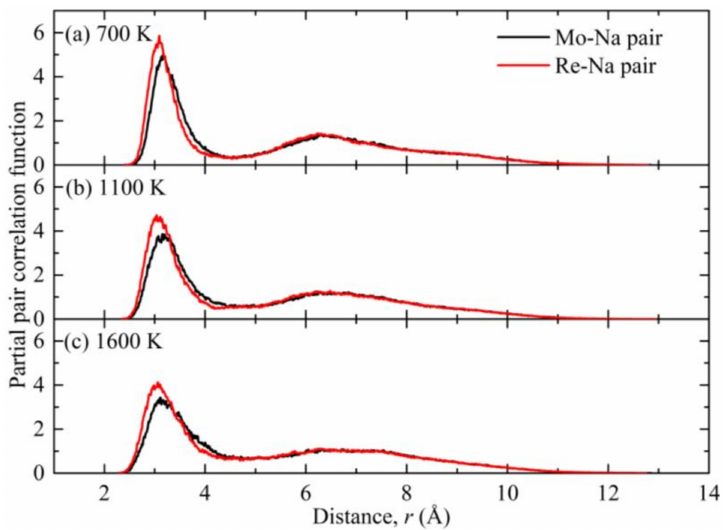
Figure 2. Partial pair correlation function of 0.5 mol/L solute atoms at the temperature of ( a ) 700 K, ( b ) 1100 K and ( c ) 1600 K.